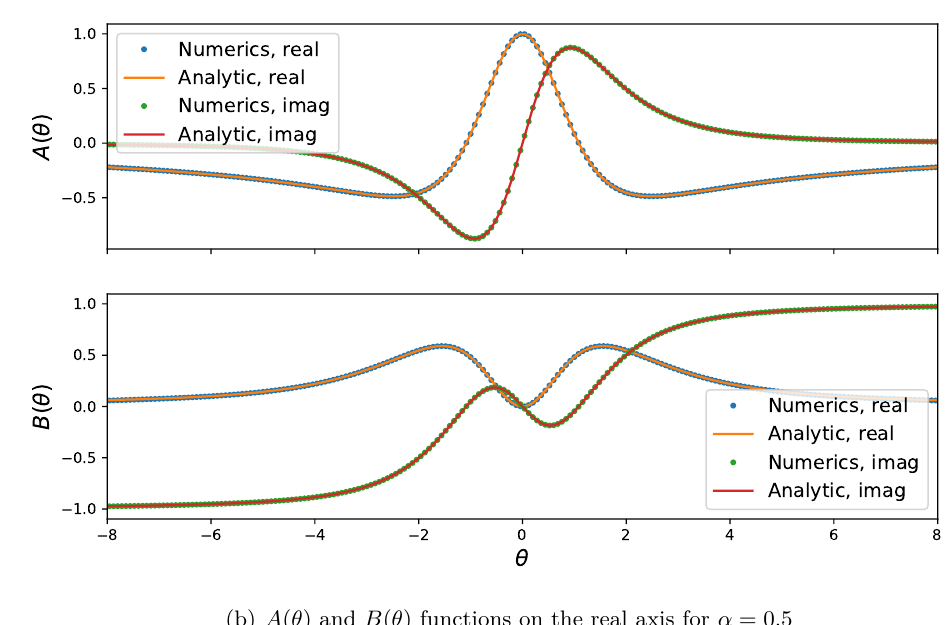
Figure 8 . Plot of A ( θ ) and B ( θ ) along the real and imaginary axis of the physical region 0 ≤ Im θ ≤ π for the off diagonal R-matrix ansatz. We find perfect agreement between the R-matrix 2 bootstrap and the exact answer from